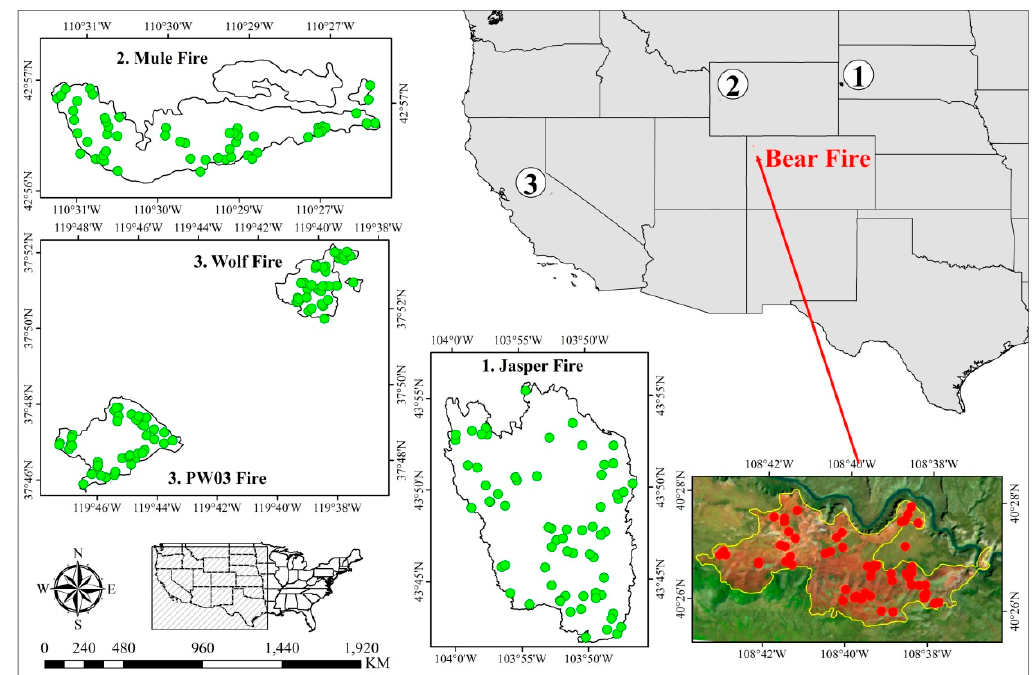
Figure 2. The location of study area in the southwest of United States. Red plots are testing data from target domain area and Green plots are training data from source domain areas.